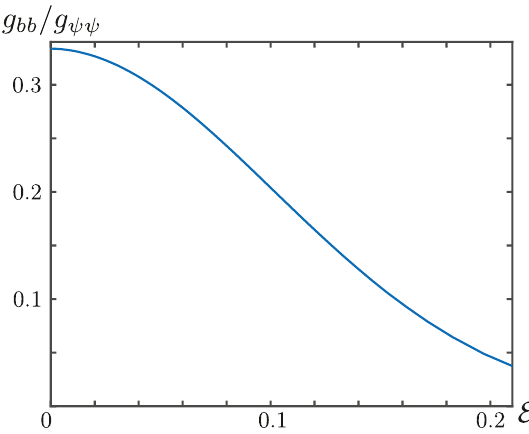
g bb , but the ψψ